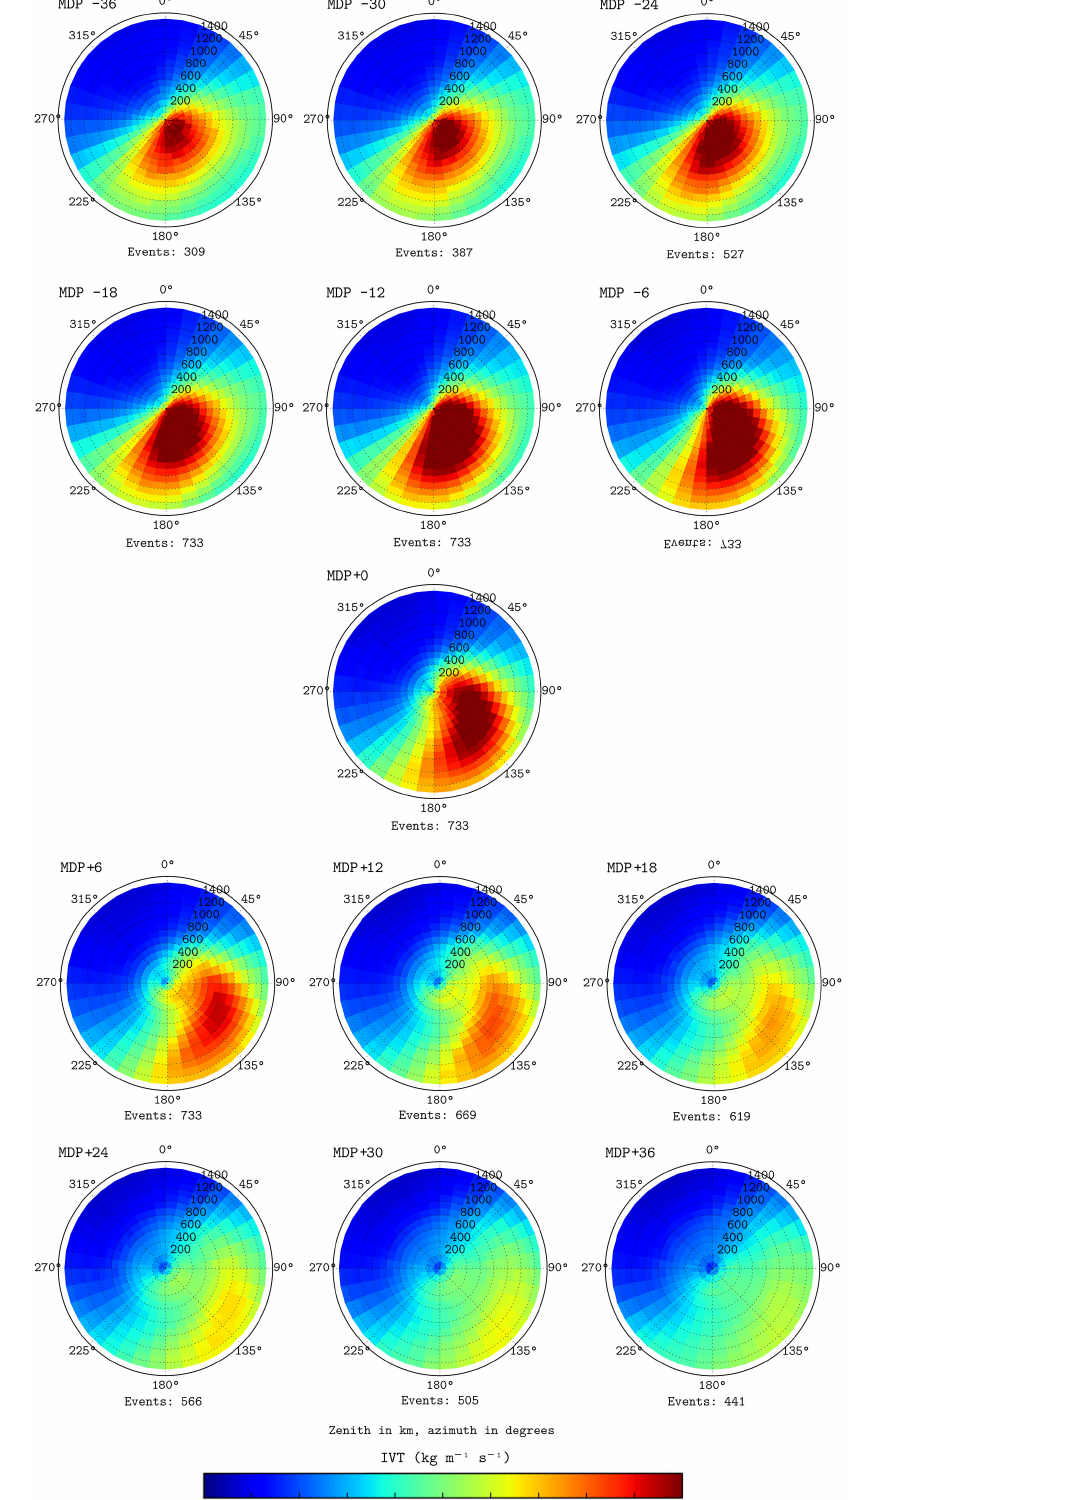
Figure 4. Composite of the integrated vapour transport (IVT, colours, kgm − 1 s − 1 ) within a 1500km radius around the cyclone core of an explosive cyclogenesis (EC) cyclone for the North Atlantic Basin for the period 1979–2011. The maximum deepening point (MDP) is fixed as time reference and results are shown for ± 36h of the